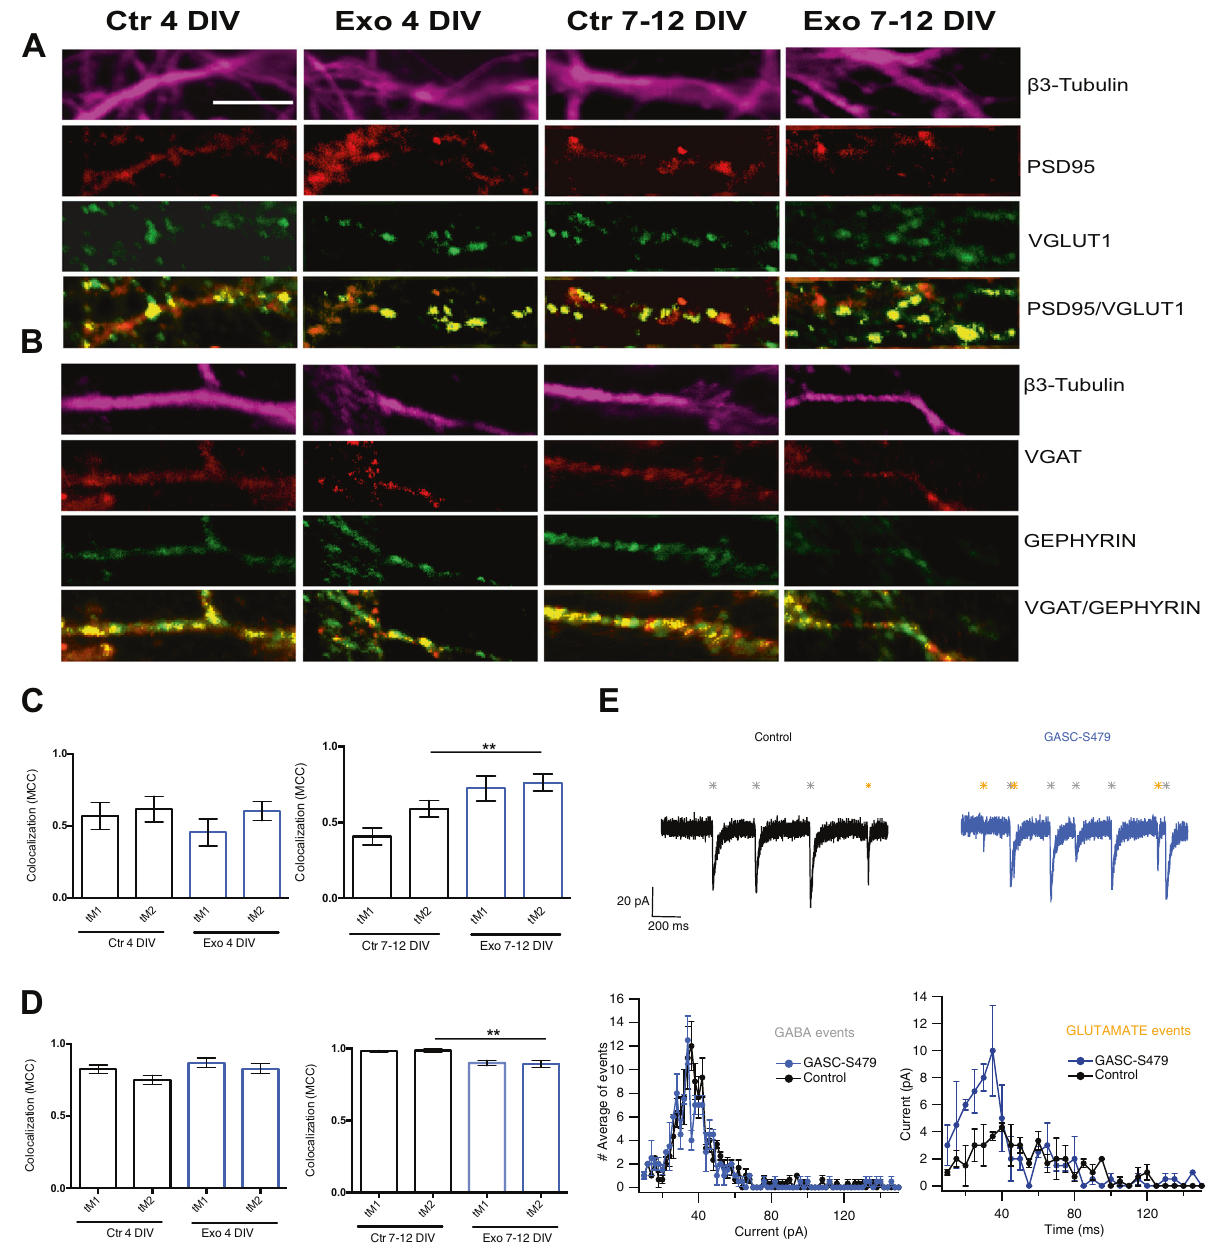
Fig. 5 U87 exosomes increase the number of excitatory synapses and decrease inhibitory synapses at DIV 7 – 12 in hippocampal neurons. A Representative confocal images of excitatory synapses of hippocampal neurons from control (Ctr) and U87 exosome-treated (Exo) groups at DIV 4 and DIV 7 – 12. Neurons were identi fi ed by β 3-tubulin staining (purple channel), and excitatory synapses were identi fi ed using double immunostaining with VGLUT1 (green channel)/PSD95 (red channel). Colocalization of pre- and post-synaptic markers is highlighted in yellow and corresponds to bona fi de excitatory synapses. C VGLUT1/PSD95 colocalization was evaluated using Mander ’ s colocalization coef fi cient (MCC). tM1 corresponds to the fraction of VGLUT1 in compartments containing PSD95, while tM2 to the fraction of PSD95 in compartments containing VGLUT1. B Representative confocal images of inhibitory synapses identi fi ed by double immunostaining with VGAT (pre-synaptic, red channel)/GEPHYRIN (post-synaptic, green channel) under the same experimental conditions shown in ( A ). D VGAT/GEPHYRIN colocalization analysis was obtained as described in ( B ). Scale bar: 5 μ m. Bar graphs show the average ± SEM of four different coverslips prepared from n = 4 distinct preparations. Unpaired Student ’ s t -test, ** p < 0.01. For each coverslip at least 10 dendrites were analyzed. E Upper panels : Representative traces from recordings in voltage-clamp (Black: Control, blue: GASC-479 exosome-treated) showing spontaneous synaptic events evoked by GABA or glutamate (Gray and orange color, respectively). Lower panels : Average peak currents distribution from the recordings at DIV 7 – 12 for control cells ( n = 3) and GASC-479 exosome-treated cells ( n = 4) in cultures with low synaptic activity. Left : GABAergic events distribution, Right : Glutamatergic events distribution (* p < 0.05 Kolmogorov – Smirnov